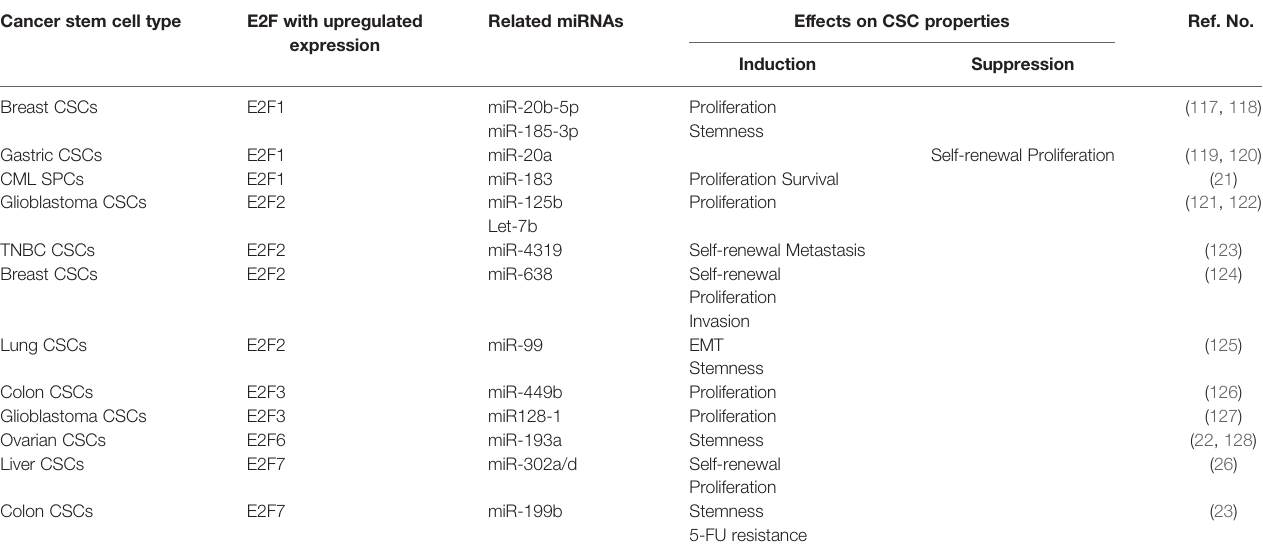
TABLE 1 | Roles of E2F-related miRNAs in regulation of cancer stem cells. Cancer stem cell